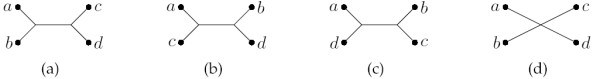
The four possible quartet topologies. The four possible quartet topologies of species a, b, c, d. Topologies (a): ab|cd, (b): ac|bd, and (c): ad|bc are butterfly quartets, while topology (d): ab×cd
 MathType@MTEF@5@5@+=feaafiart1ev1aaatCvAUfKttLearuWrP9MDH5MBPbIqV92AaeXatLxBI9gBaebbnrfifHhDYfgasaacH8akY=wiFfYdH8Gipec8Eeeu0xXdbba9frFj0=OqFfea0dXdd9vqai=hGuQ8kuc9pgc9s8qqaq=dirpe0xb9q8qiLsFr0=vr0=vr0dc8meaabaqaciaacaGaaeqabaqabeGadaaakeGadiahceaGeaapguaabeqaceaaaeaacqWGHbqyaeaacqWGIbGyaaGaey41aqBbaeqabiqaaaqaaiabdogaJbqaaiabdsgaKbaaaaa@3501@, is a star quartet.